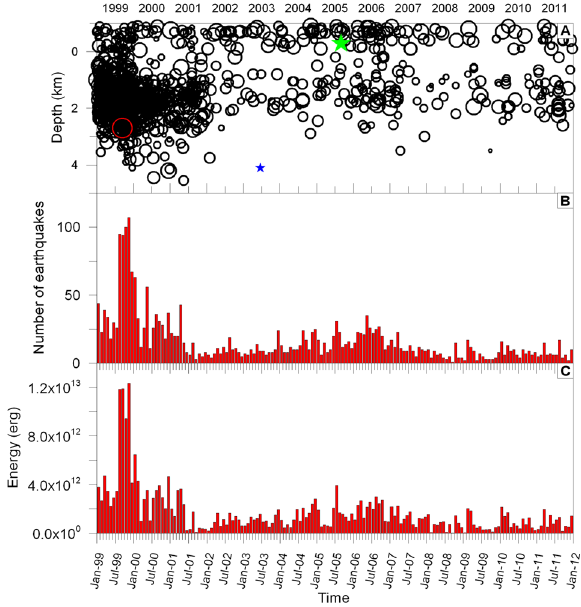
Figure 3. Seismic parameters of Mt. Vesuvius VT earthquakes from 1999 to 2011: (A) source depth (km); (B) monthly distribution of number of events; (C) energy (erg). The reported data are extracted from OV historical catalogue for the period January 1999-December 2011. The size of each symbol in panel A is proportional to the mag- nitude. The blue star indicates the July 20, 2003, Long Period earth- quake, the green star the August 30, 2005, earthquake and the red 3.6 circle the October 9, 1999, M D